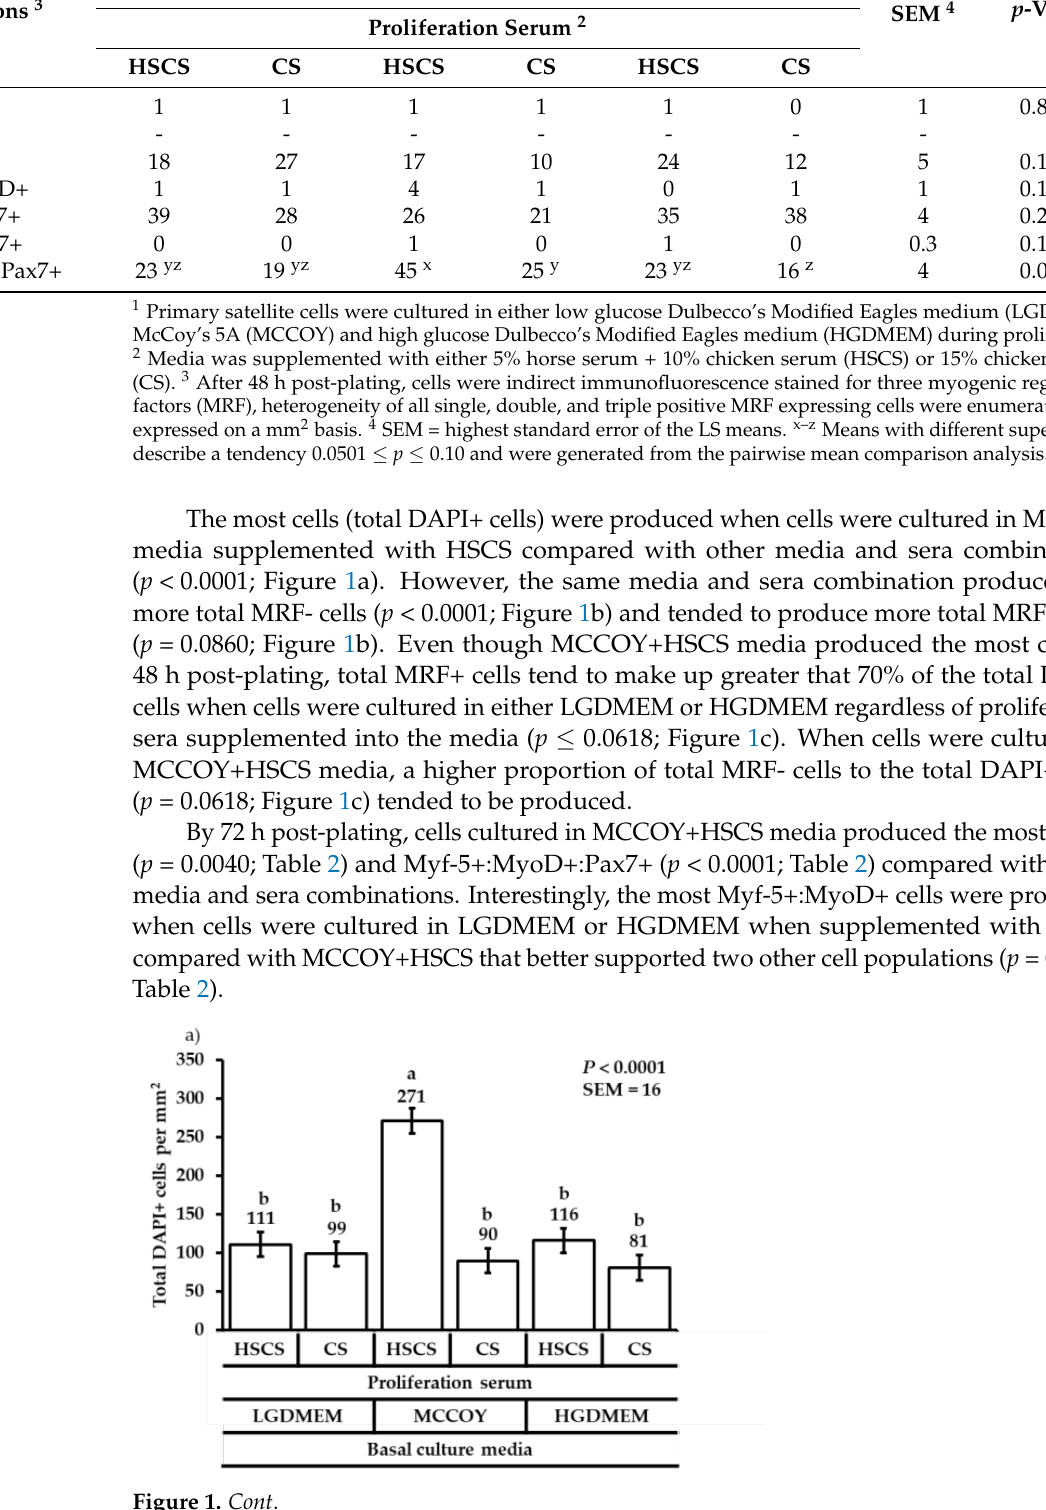
Figure 1. The effect of basal culture media and proliferation sera on total DAPI+ cells ( a ), total MRF+ and total MRF- cells ( b ), and proportions of total MRF+ or total MRF- cells to total DAPI+ cells ( c ) at 48 h post- plating. Cells were cultured in either low glucose Dulbecco’s Modified Eagles medium (LGDMEM), McCoy’s 5A (MCCOY), or high glucose Dulbecco’s Modified Eagles medium (HGDMEM) supplemented with either 5% horse serum + 10% chicken serum (HSCS) or 15% chicken serum (CS). a – c Means with different superscripts describe a difference p < 0.05 and were generated from the pairwise mean comparison analysis. x – z Means with different superscripts describe a ten- dency 0.0501 ≤ p ≤ 0.10 and were generated from the pairwise mean comparison analysis. Following similar results at 48 h post-plating, the most cells (total DAPI+ cells) were produced when cells were cultured in MCCOY+HSCS compared with the other media and sera combinations ( p < 0.0001; Figure 2a). The same media and serum combination also produced the most total MRF+ ( p = 0.0001; Figure 2b), and total MRF- ( p < 0.0001; Figure 2b) cell populations. It is not surprising that more than 40% of the total cells cul- tured in MCCOY+HSCS were MRF- with MCCOY+CS having the second highest percent- age of MRF- cells ( p = 0.0340; Figure 2c). Nevertheless, both DMEM media supported